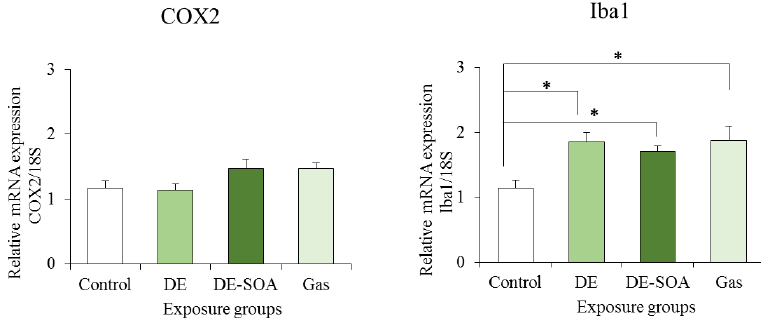
Figure 5. Effects of DE or DE-SOA on the expression of the inflammatory marker COX2 and microglial marker Iba1 in the hippocampi of the preweaning mice ( n = 6–8, * p < 0.05 vs.